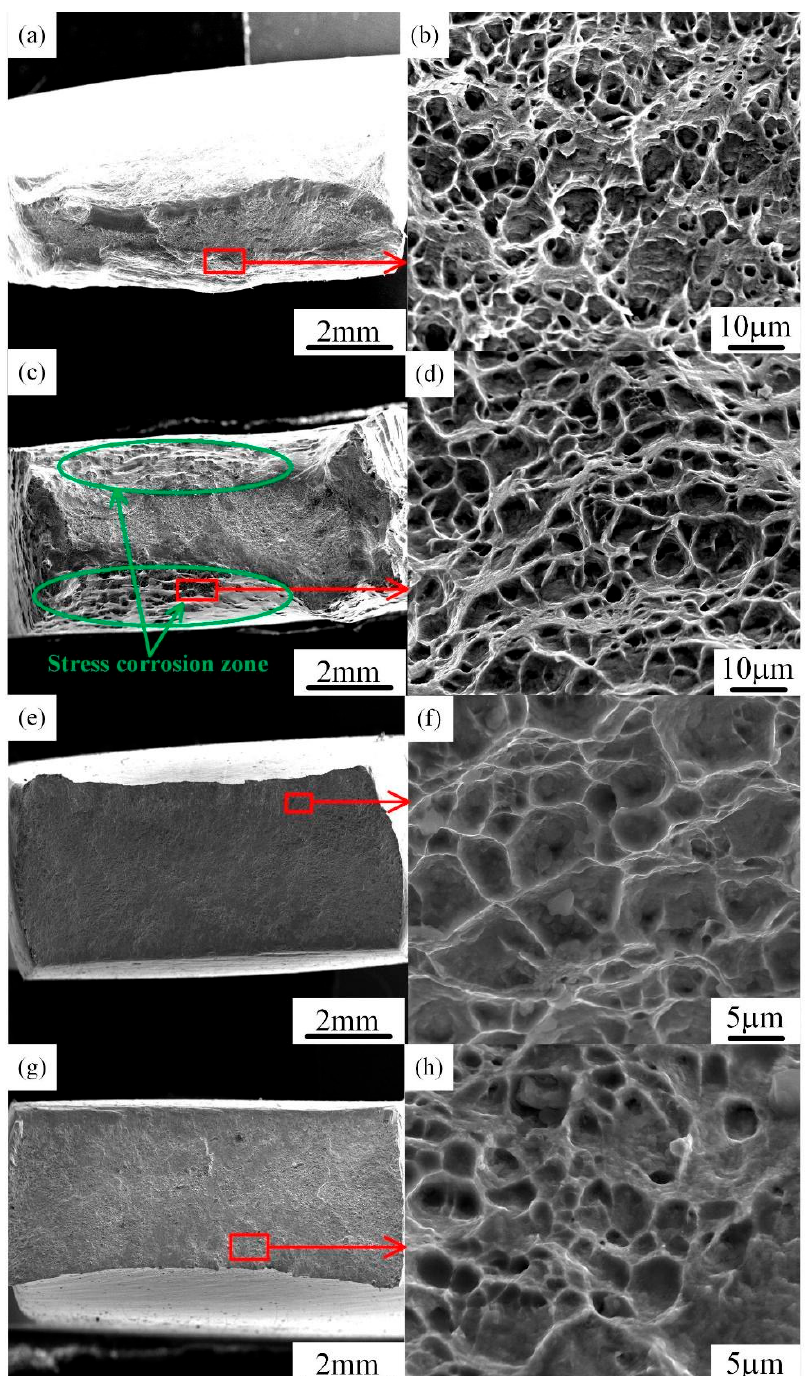
Figure 4. ( a ) Low- and ( b ) high-magnification scanning electron microscopy (SEM) fractographs